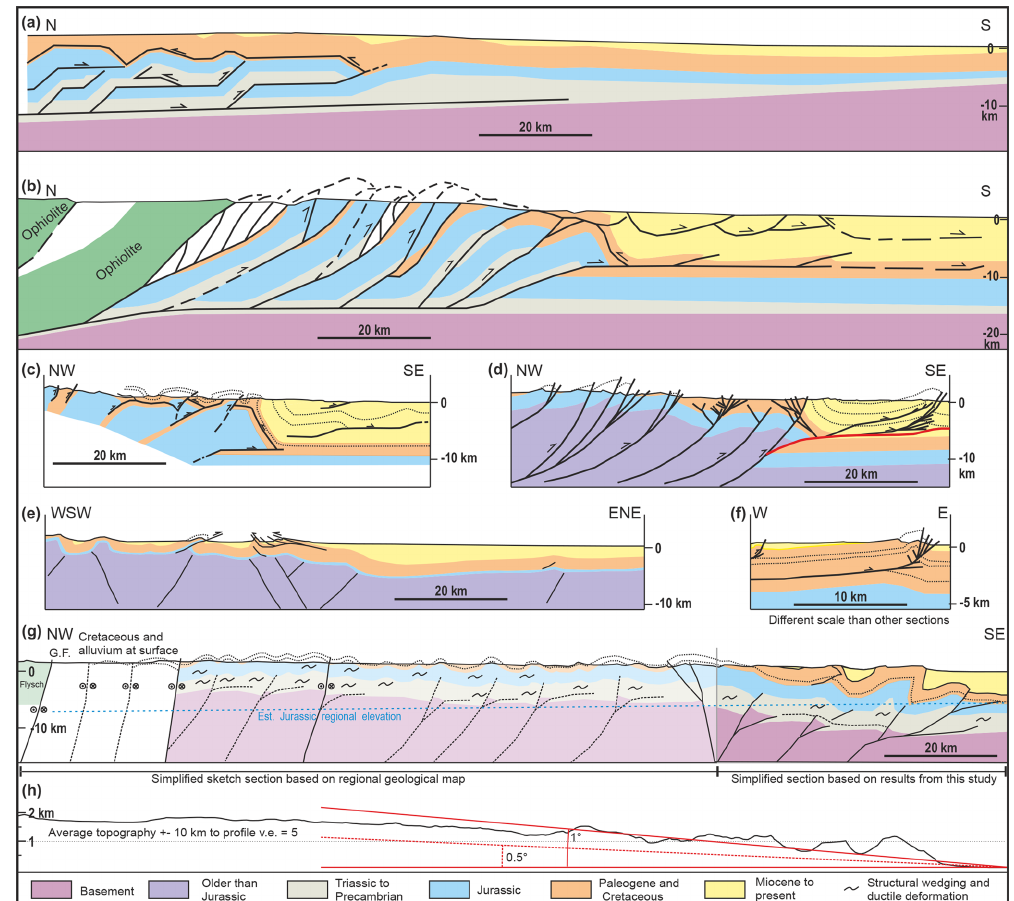
Figure 2. Selected sections in the southern western fold belt of Pakistan (for section locations see Figs. 1, 3). (a) After Jadoon et al. (1992), (b, c) after Banks and Warburton (1986), (d) after Szeliga et al. (2009); red line indicates the approximate shape of the fault considered responsible for the 1931 Mach event. (e) After Fowler et al. (2004), (f) after Schelling (1999), (g) this study; the frontal part (strong colours) is a slightly projected section elaborated for the northern sector of this study area. The western part is a tentative regional sketch section based on the geological map of Bannert et al. (1992), as shown in Fig. 3. G.F.: Ghazeraband fault. (h) Average topography of a 20km wide section centred on the trace of (g) with 5 times vertical